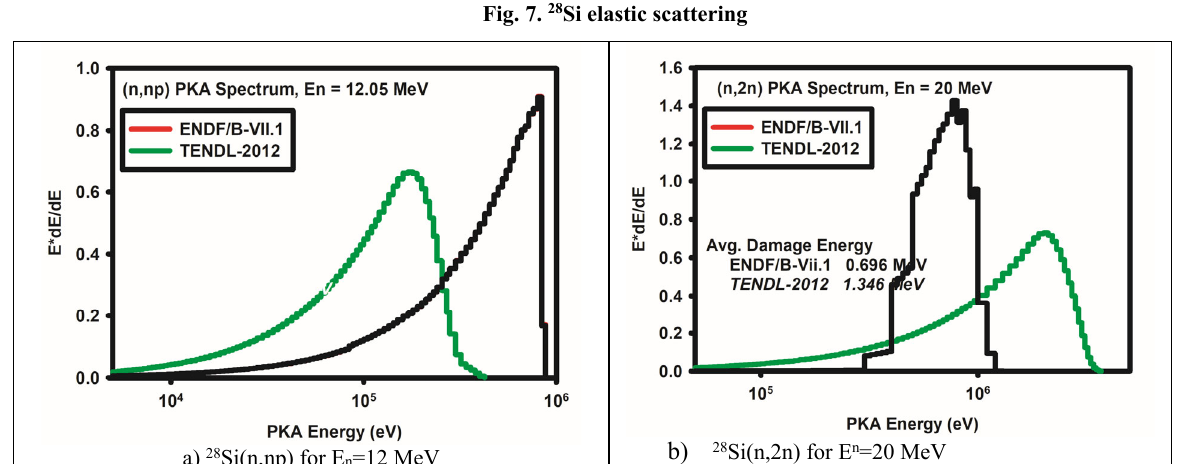
Fig. 8. 28 Si primary recoil atom spectra from transmutation reaction